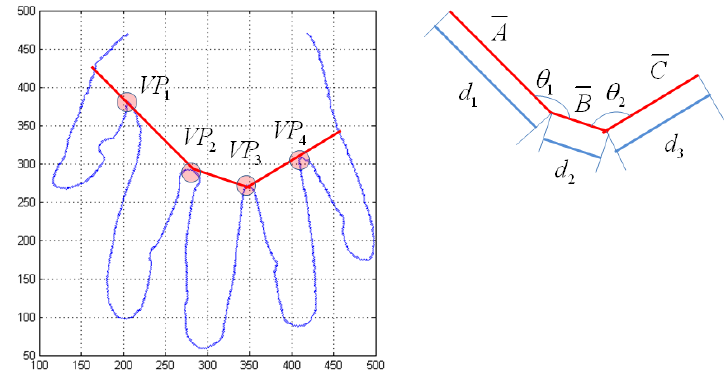
Figure 9. The feature extraction for lengths and angles of finger